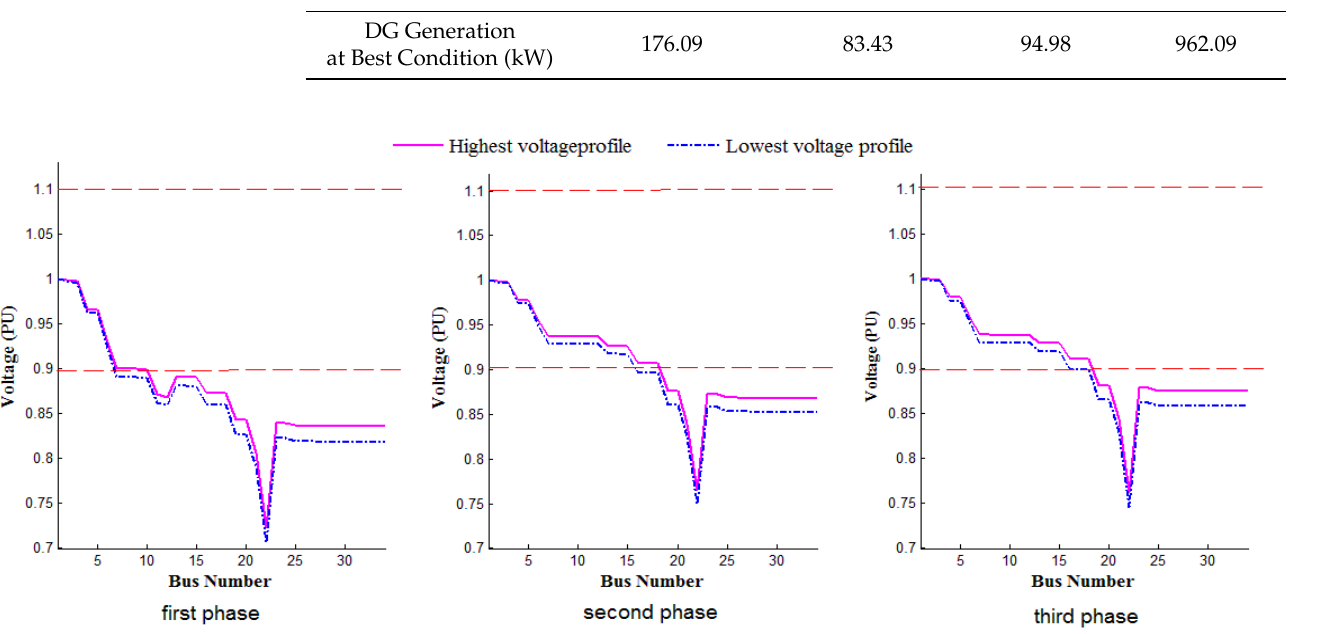
Figure 8. Voltage profiles after optimal placement and sizing of RES units.